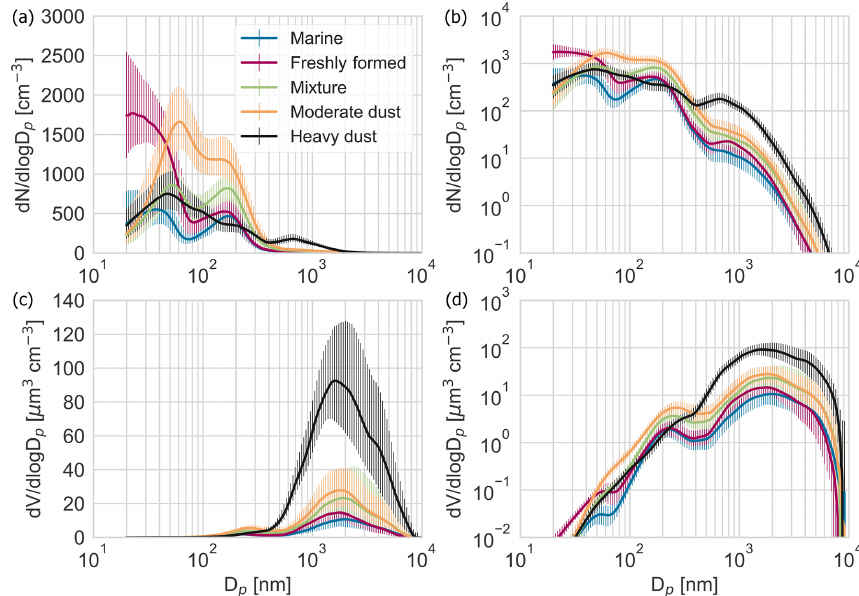
Figure 7. The median of PNSDs (a, b) and PVSDs (c, d) of marine (blue), freshly formed (purple), mixture (green), moderate dust (brown) and heavy dust (black) clusters with a linear (a, c) and a logarithmic (b, d) scaling on the y axis. Error bars show the range between 75th and 25th percentiles.